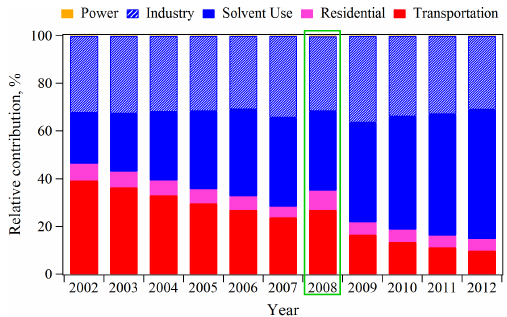
Figure 2. Relative contributions of transportation, residential ac- tivities, solvent use, industry, and power plants to anthropogenic NMVOC emissions in Beijing during August from 2002 to 2012 reported by the MEIC inventory